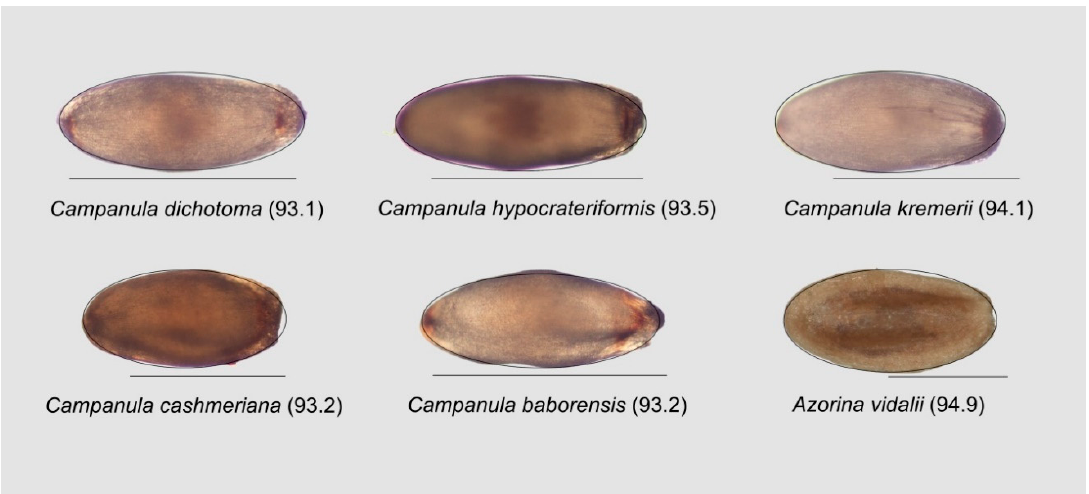
Figure 15. Seeds resembling an ellipse (Campanulaceae). The values indicated correspond to J index in the images shown and do not represent mean values for each particular species. Bar equals 0.5 mm.